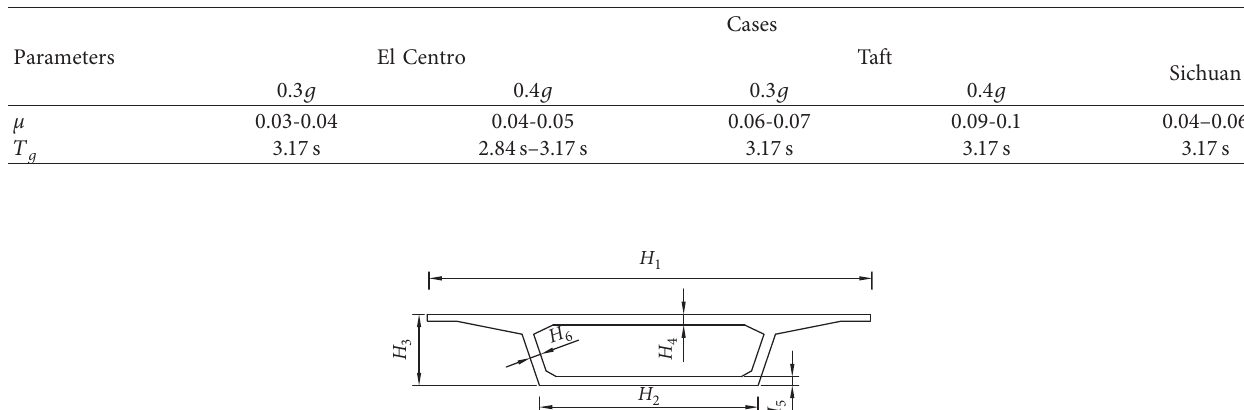
Figure 18: Seismic response amplitude (Taft, peak acceleration 0.4 g ). (a) Structural response energy; (b) energy consuming ratio; (c) acceleration amplitude of the main beam; (d) displacement amplitude of the main beam. Table 5: The optimal parameters in different cases.